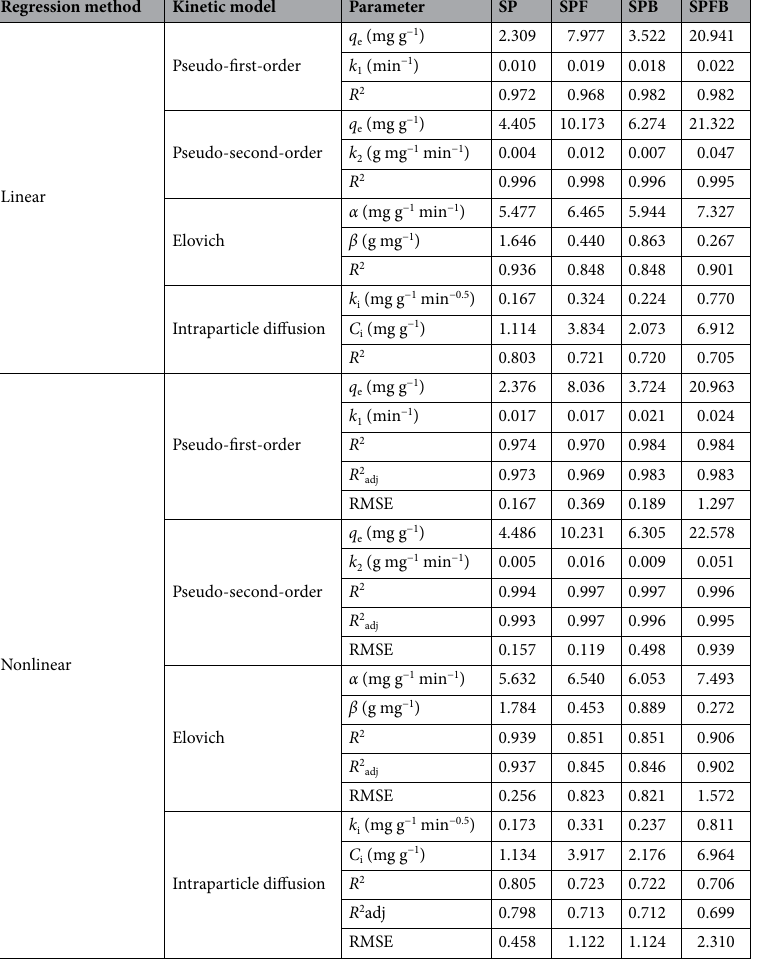
Table 7. The comparison of linear and nonlinear kinetic parameters for lead adsorptions on sawdust powder (SP), sawdust powder doped iron (III) oxide-hydroxide (SPF), sawdust beads (SPB), and sawdust powder doped iron (III) oxide-hydroxide beads